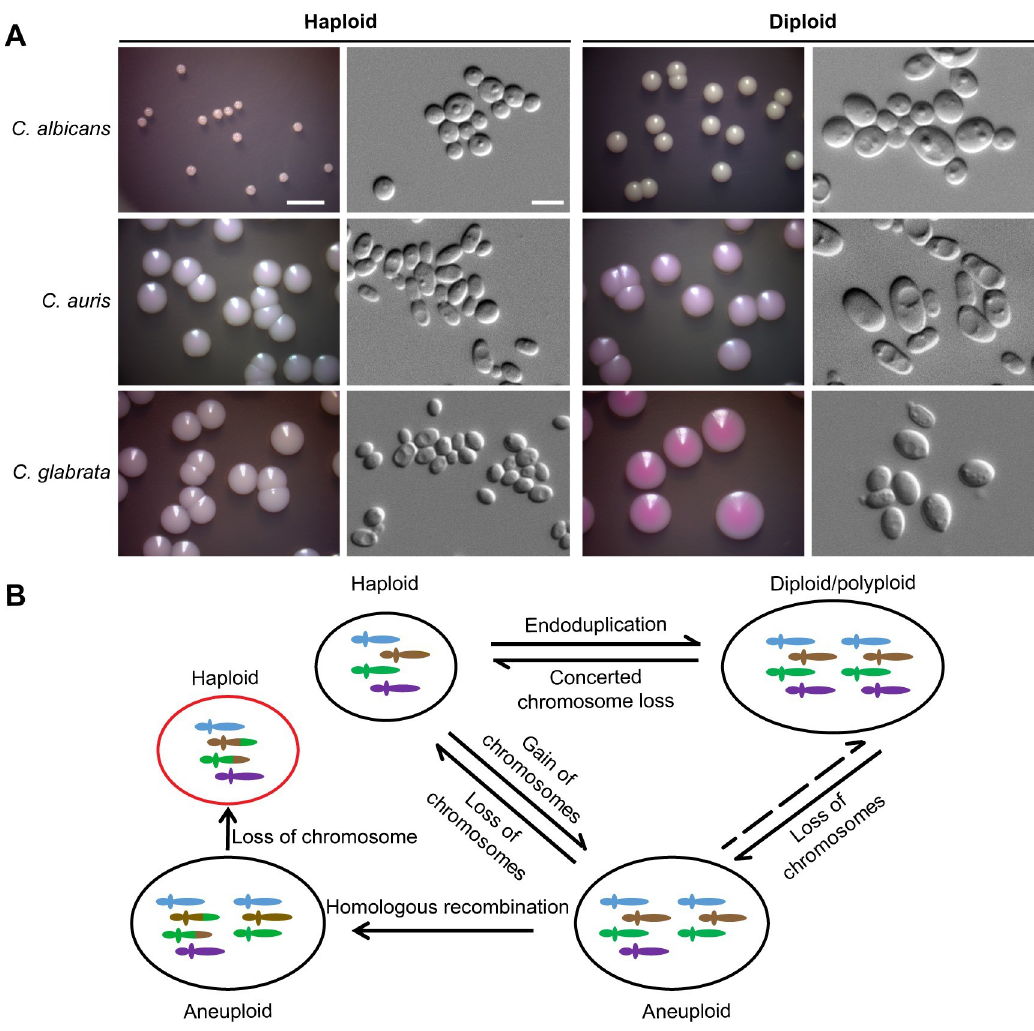
Fig 1. Ploidy changes in pathogenic fungi. (A) Colony and cellular morphologies of haploid and diploid forms of C . albicans (SC5314), C . auris (BJCA001), and C . glabrata (FK83). Cells were plated on YPD medium (BJCA001 and FK83 cells) or SCD medium (SC5314 cells) containing 5 μ g/mL phloxine B and incubated at 30˚C for 4 days. Scale bar for colonies, 5 mm; scale bar for cells, 5 μ m. (B) Schematic diagram of ploidy changes. Fungal cells may undergo ploidy changes spontaneously or in response to environmental stresses. Cells of lower ploidy (e.g., haploid) can adopt a higher ploidy (diploid, tetraploid, or polyploid), which are subsequently able to return to the lower ploidy state through chromosome non-disjunction events that lead to concerted chromosome loss. Fungal cells are also able to switch between euploid and aneuploid states through gain or loss of chromosomes. Aneuploid and non-baseline ploidy states are often unstable and can give rise to additional genetic